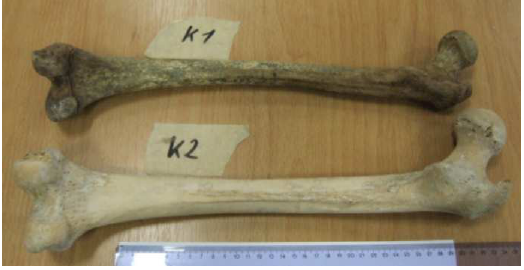
Figure 2. View of two female femur